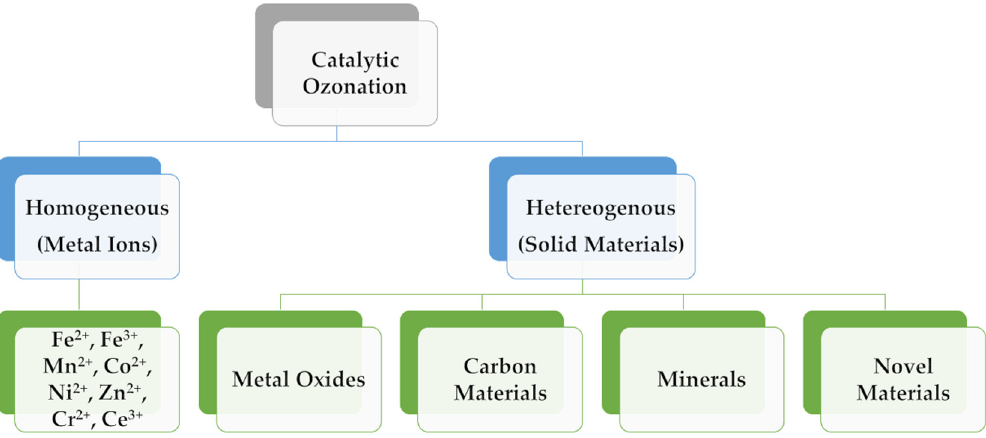
Figure 1. Classification of catalysts used in catalytic ozonation based on Nawrocki, 2010 [44].